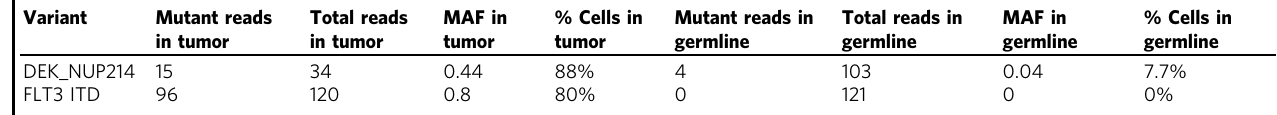
Table 1 Variant frequencies in AML with residual tumor in the germline sample